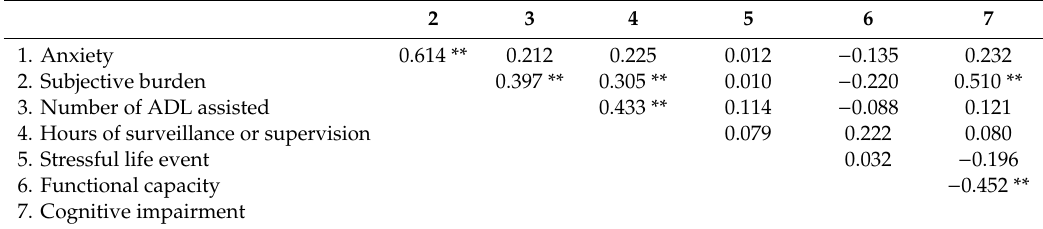
Table 2. Correlation matrix and descriptive data of the variables used in the